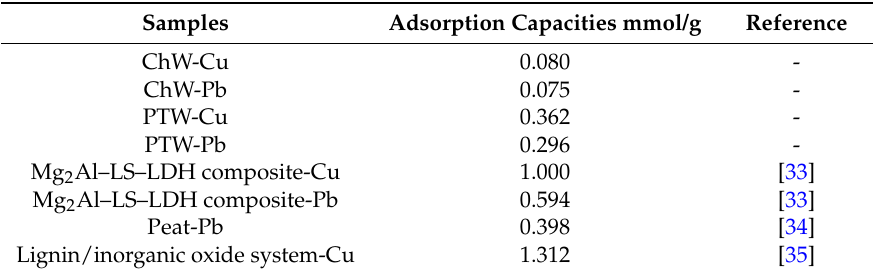
Table 1. The adsorption capacities of ChW, PTW, and a comparison with other adsorbents.